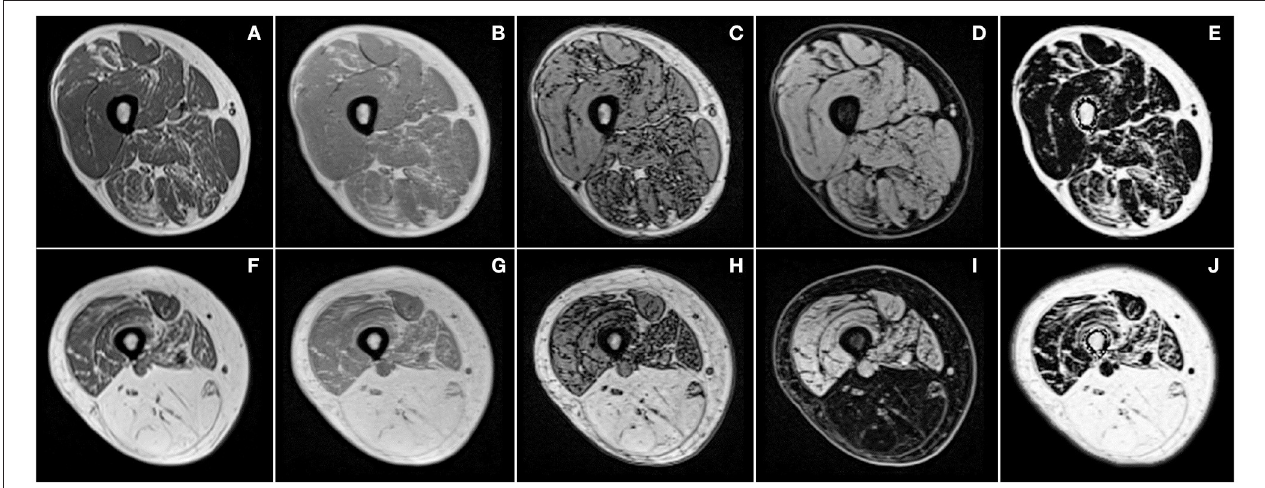
FIGURE 3 | Examples of T 1 -weighted images (A,F) and images produced by chemical shift-based water-fat separation MR sequences for the thigh of two patients (first and second row) with different severity of facioscapulohumeral muscular dystrophy. Illustrations correspond to in-phase (B,G) , out-of-phase (C,H) , water (D,I) images, and quantitative fat fraction map (E,J)